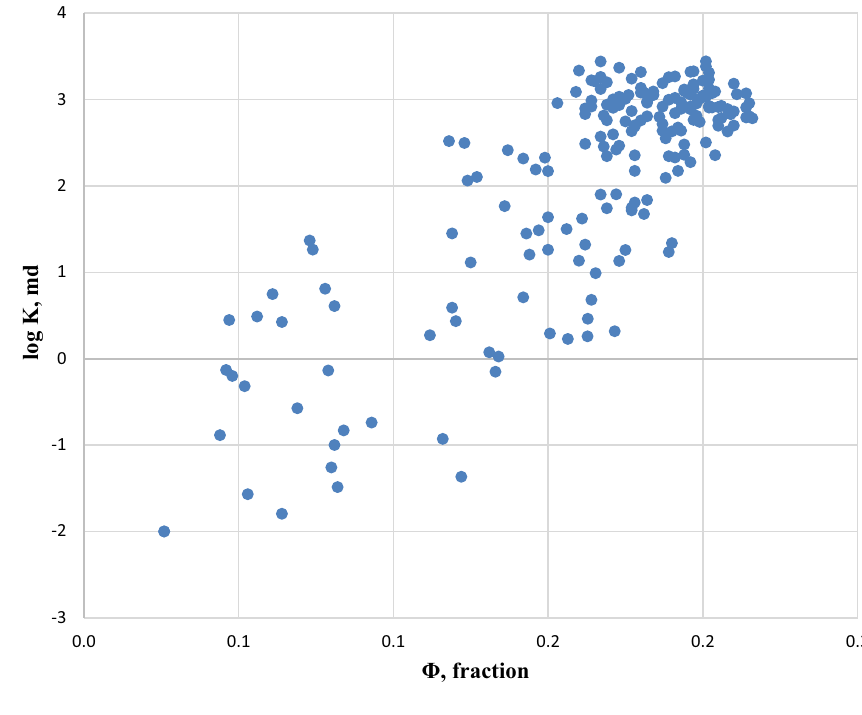
Fig. 5 Histogram of log FZI of the studied cored